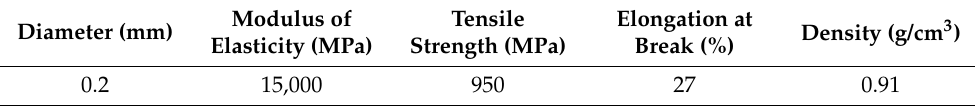
Table 2. Properties of fiber given by the supplier.